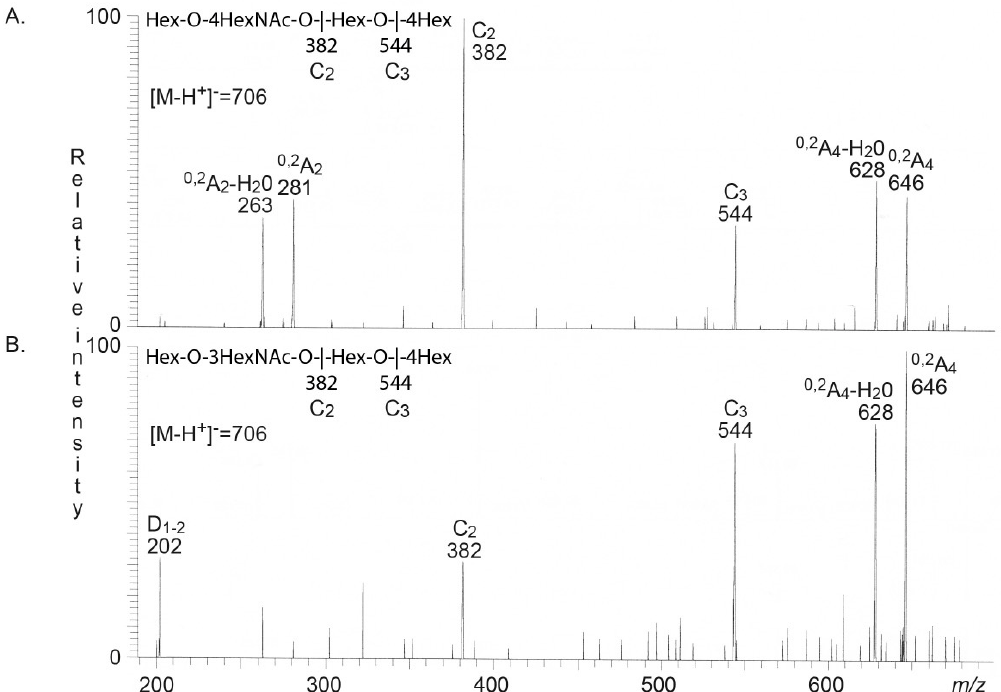
Figure 3. Characterization of the A. baumannii binding glycosphingolipids isolated from human and rabbit small intestine. ( A ) MS 2 spectrum of the ion at m / z 706 (retention time 21.4 min) from